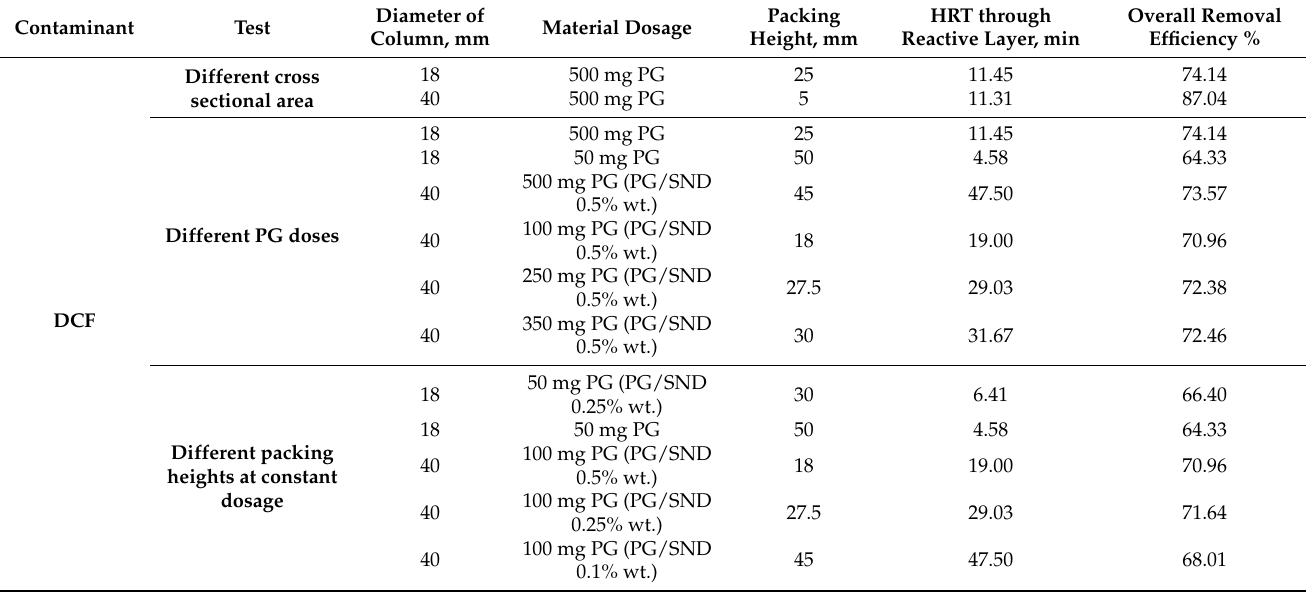
Table 5. Hydraulic retention time and overall removal efficiency of IBP removal by column filters of different cross sectional areas, PG doses, and packing heights at constant dosage. Experimental conditions: ECs-contaminated DW influent adjusted at 10.5 mg/L of EC; room temperature at 22 ± 3 ◦